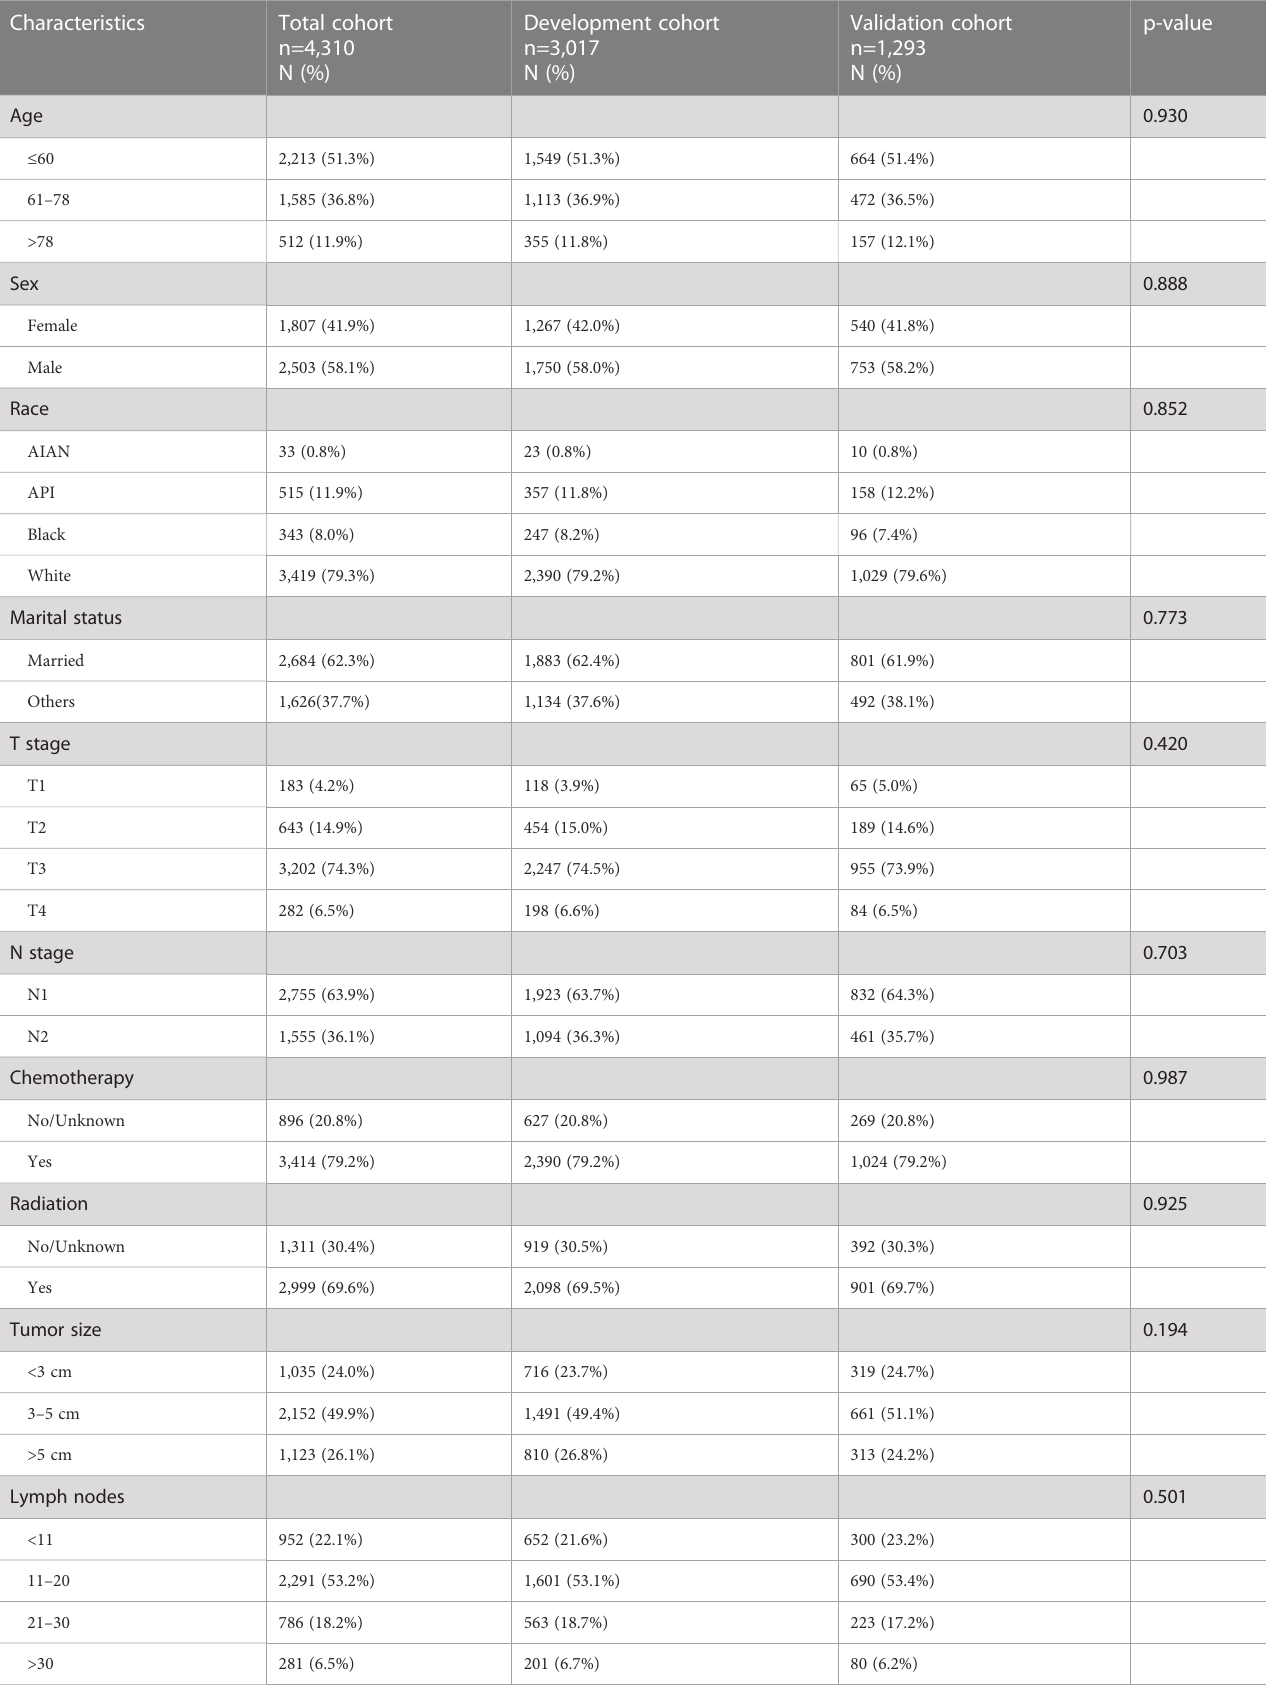
TABLE 1 Baseline demographic and clinical characteristics of lymph- node-positive rectal cancer patients in the development and validation cohorts.